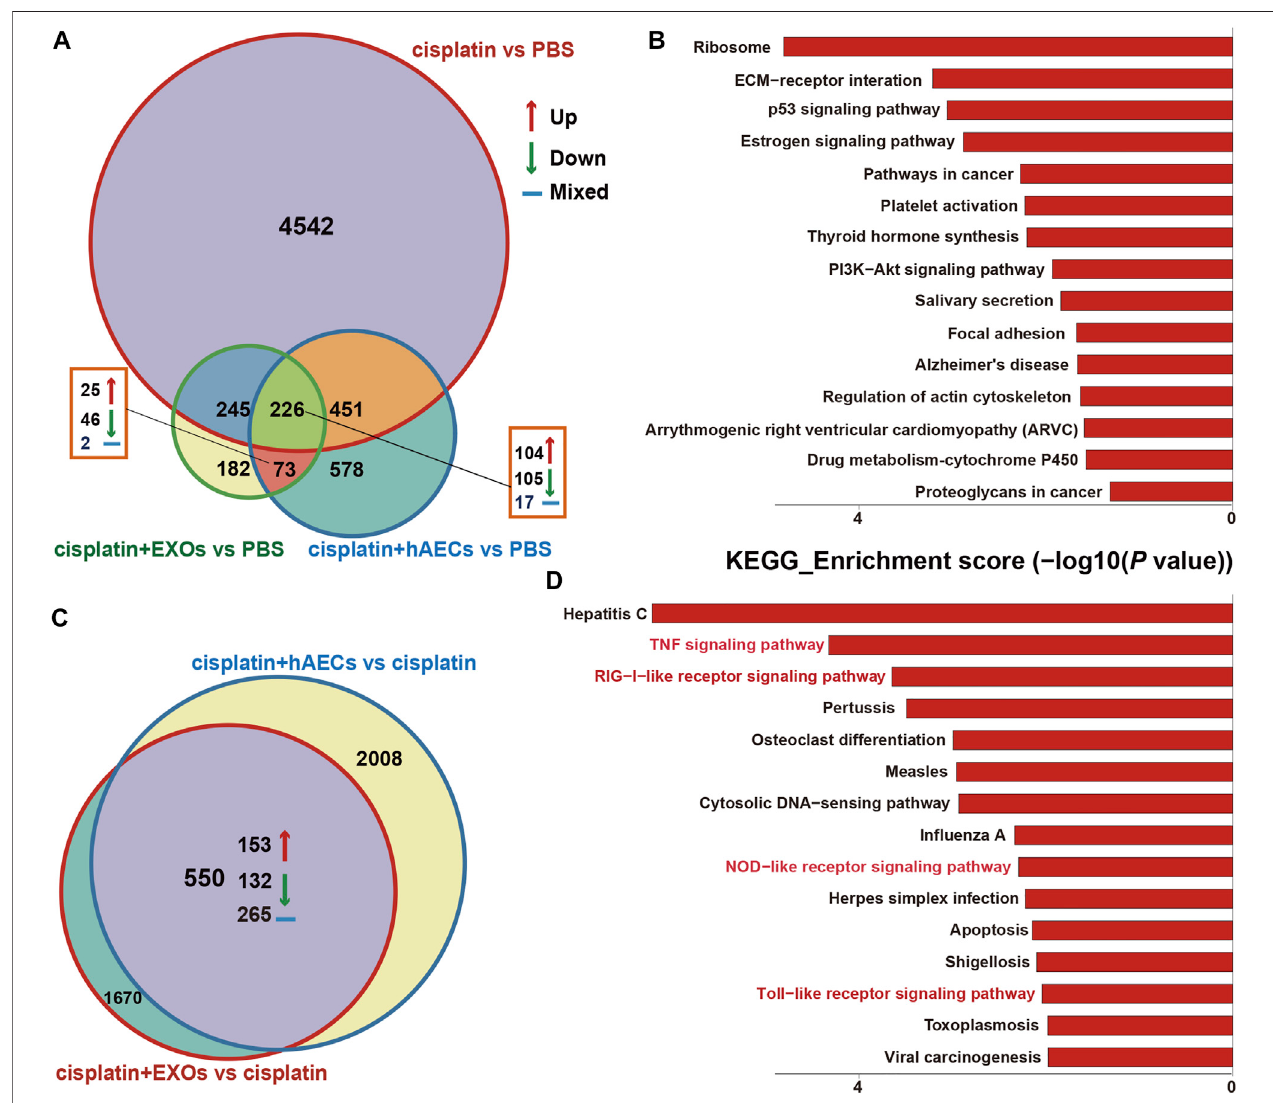
FIGURE6| RNAsequencinganalysisontumorsfromA549NSCLCnudemicecollected4 daysafter cisplatininjection. (A) Venndiagramshowingthenumbersof signi fi cant DEGs across the four groups as indicated. (B) The top 15 enriched and upregulated KEGG pathways in the 226 DEGs across the four groups as indicated in (A) . (C) Venn diagram showing the numbers of signi fi cant DEGs across the two groups as indicated. (D) The top 15 enriched and upregulated KEGG pathways in the 550 DEGs across the four groups as indicated in (C) .